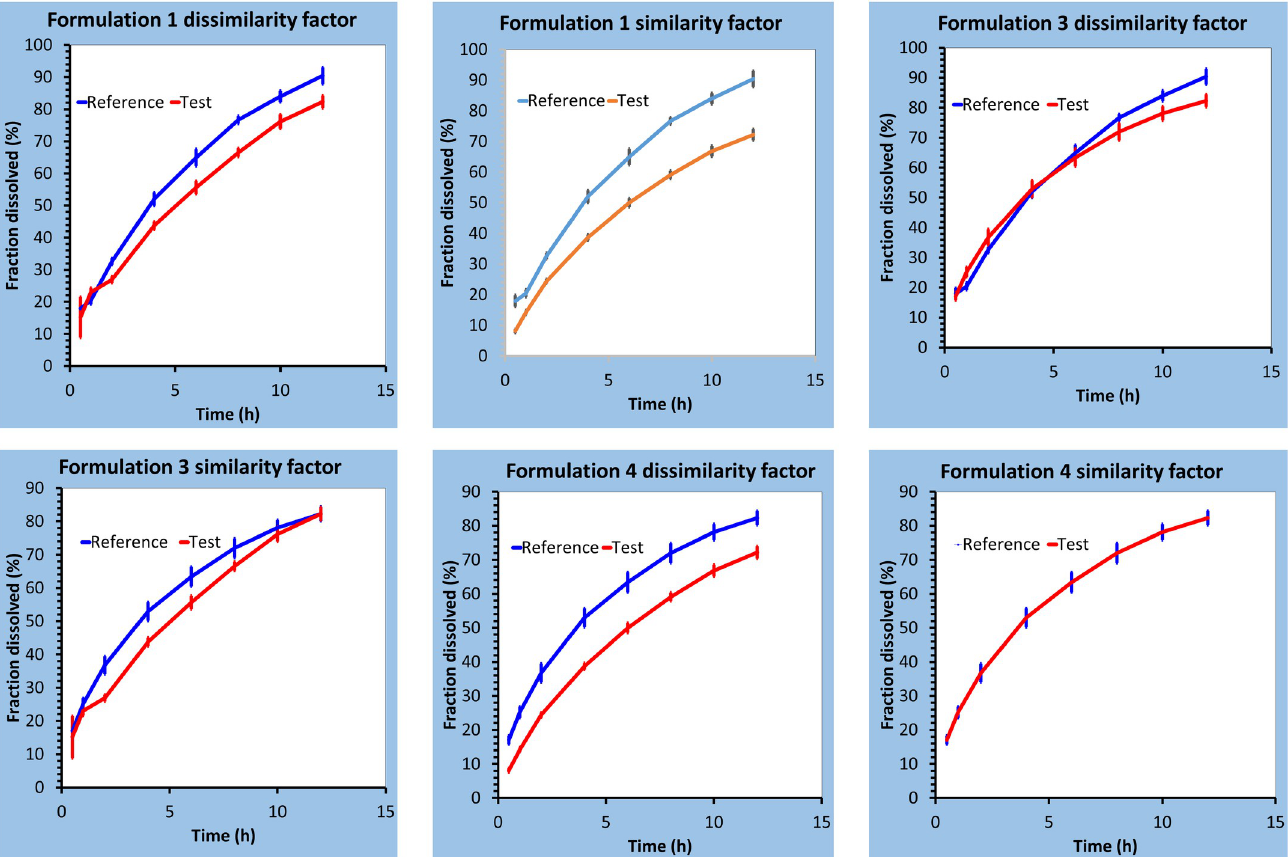
Fig 5. Graphical representation of a pairwise comparison of f1 and f2 factors of propranolol HCl formulations using F2 formulation as reference.